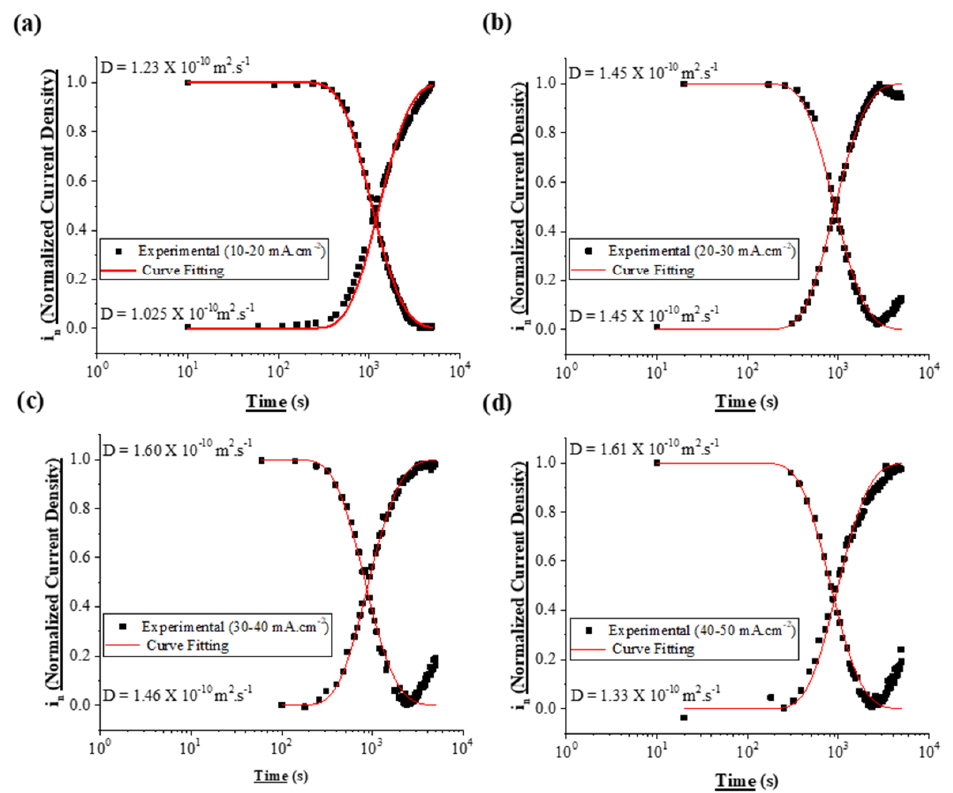
Figure 7. Partial Permeation Transients for DP800. ( a ) Rise Transient from −10 to −20 m·cm −2 and Fall transient from −20 to −10 mA·cm −2 . ( b ) Rise Transient from −20 to −30 mA·cm −2 and Fall transient from −30 to −20 mA·cm −2 . ( c ) Rise Transient from −30 to −40 mA·cm −2 and Fall transient from −40 to −30 mA·cm −2 . ( d ) Rise Transient from −40 to −50 mA·cm −2 and Fall transient from −50 to −40 mA·cm −2 .